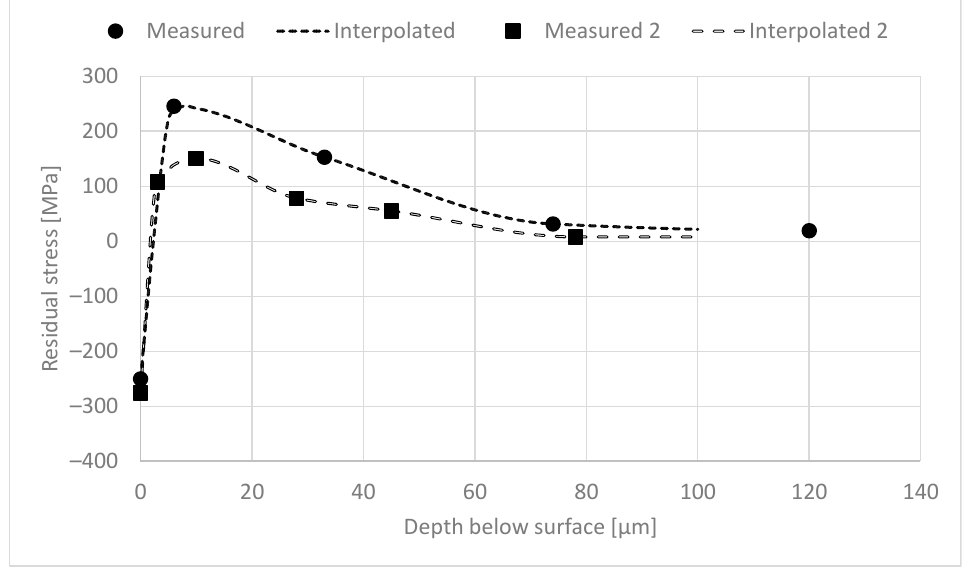
Figure 3. Two examples of RS depth profiles.